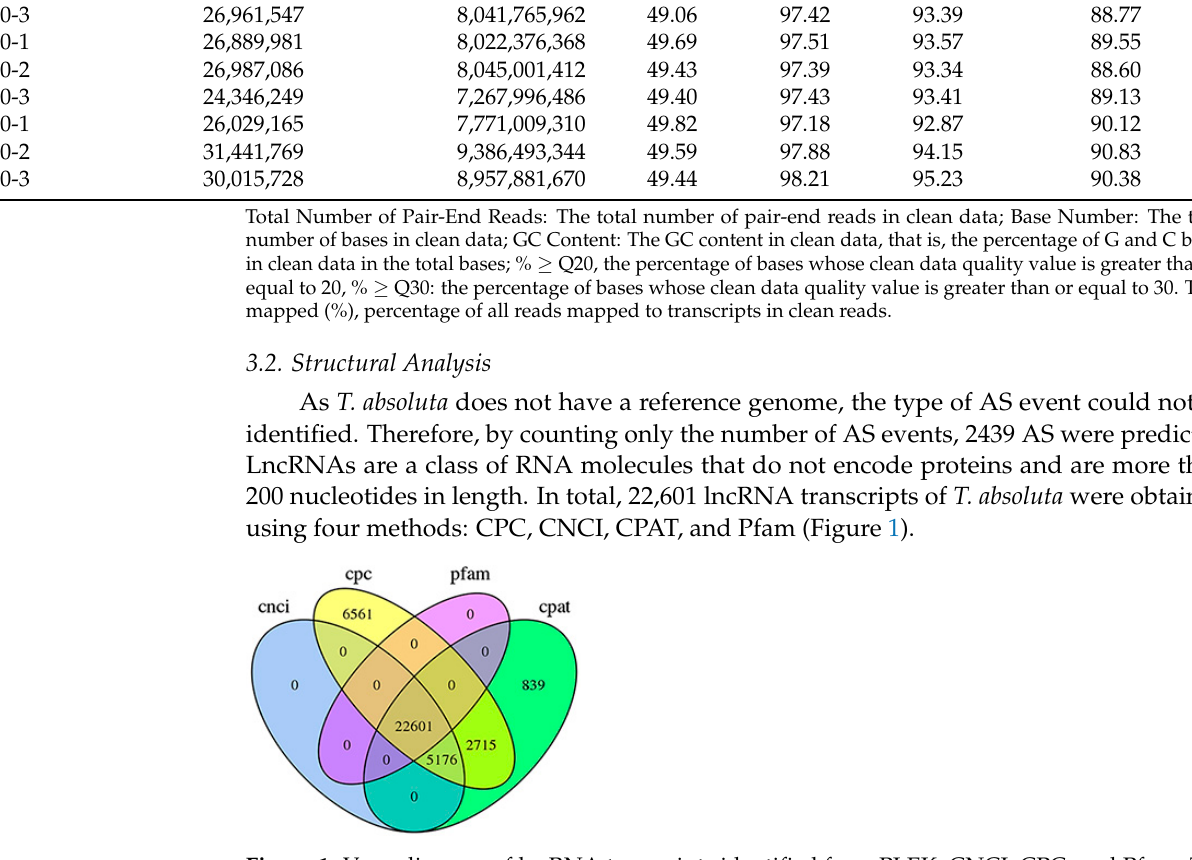
Table 1. RNA-seq data evaluation statistics table.